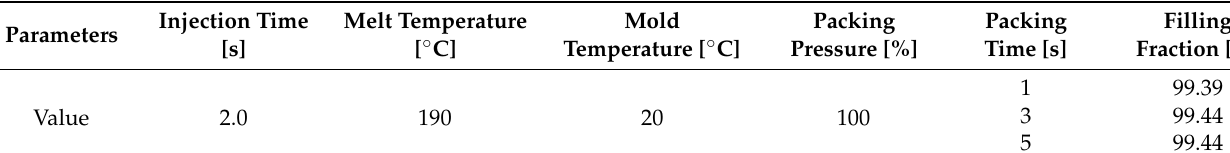
Table 7. Processing parameters of the packing time study.